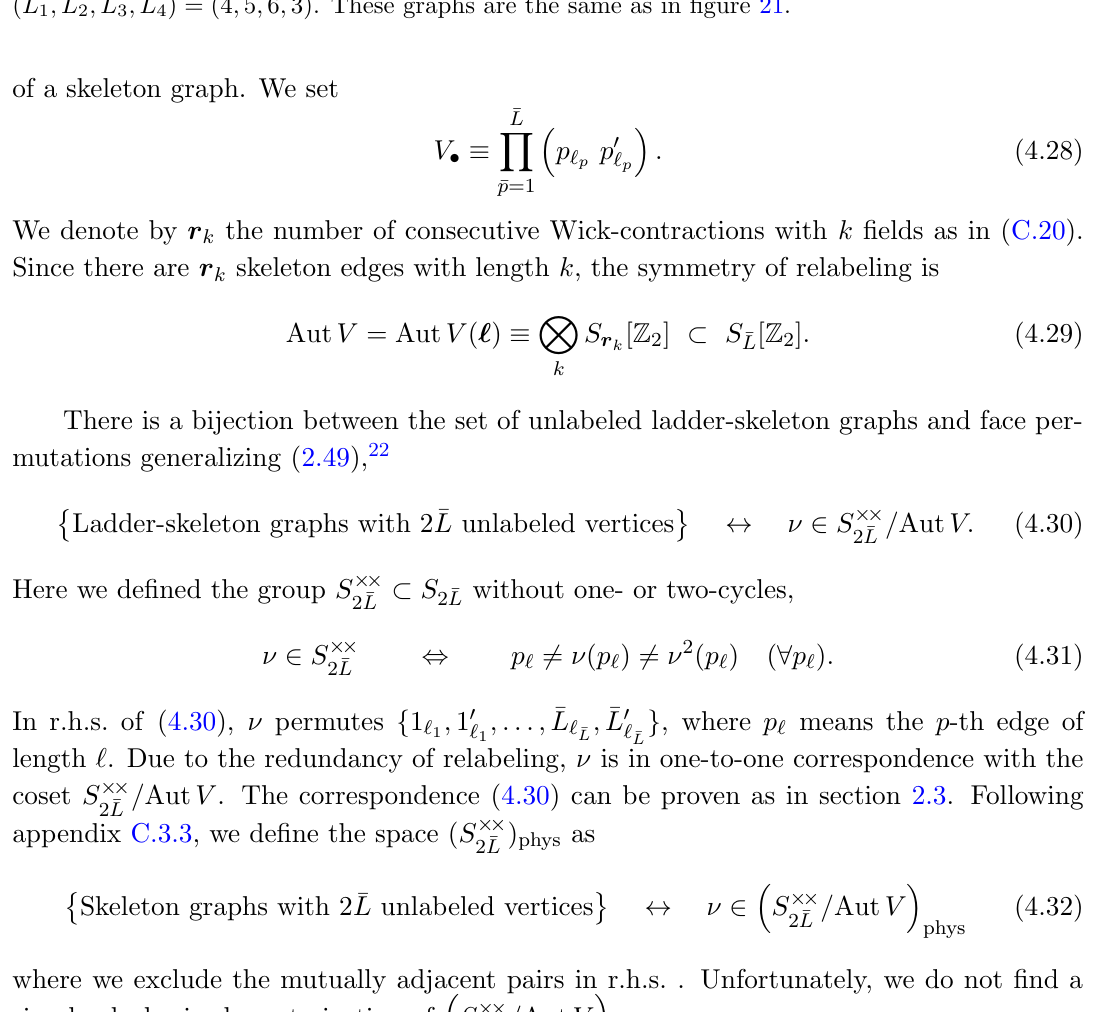
Figure 10 . Skeleton reduction of a set of the Wick-contractions in hO 1 O 2 O 3 O 4 i with ( L 1 ; L 2 ; L 3 ; L 4 ) = (4 ; 5 ; 6 ; 3). These graphs are the same as in (cid:12)gure